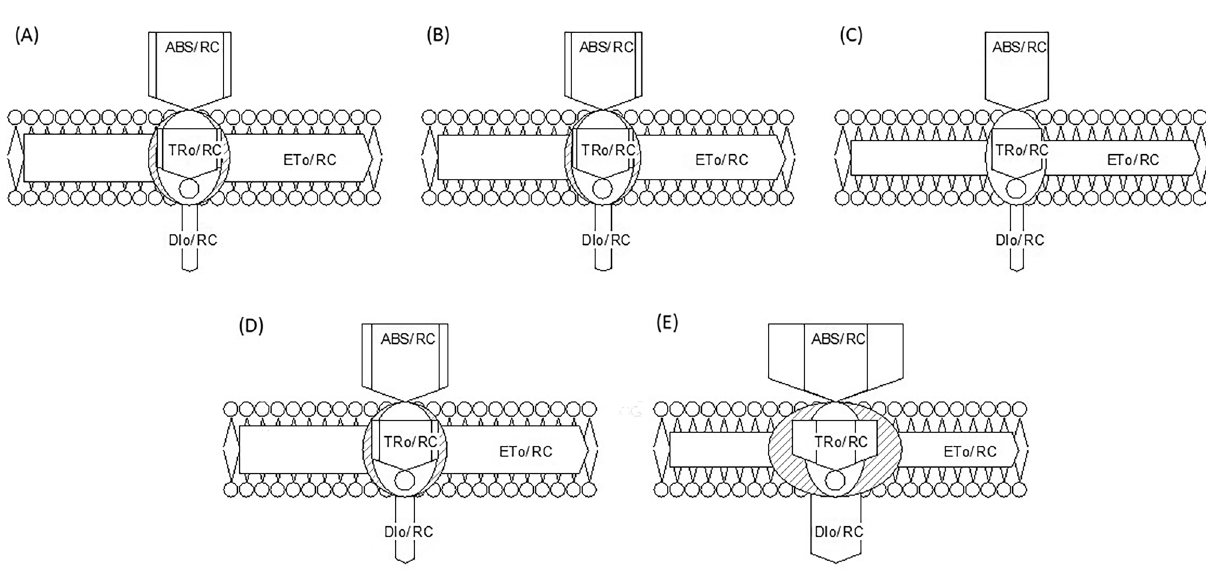
Figure 4. Thylakoid membrane model for specific energy fluxes (per reaction, RC) in L. minor fronds when subjected to various concentration of CuSO 4 , ( A ); control, ( B ); 10.0 µM, ( C ); 20.0 µM, ( D ); 30.0 µM and ( E ); 40.0